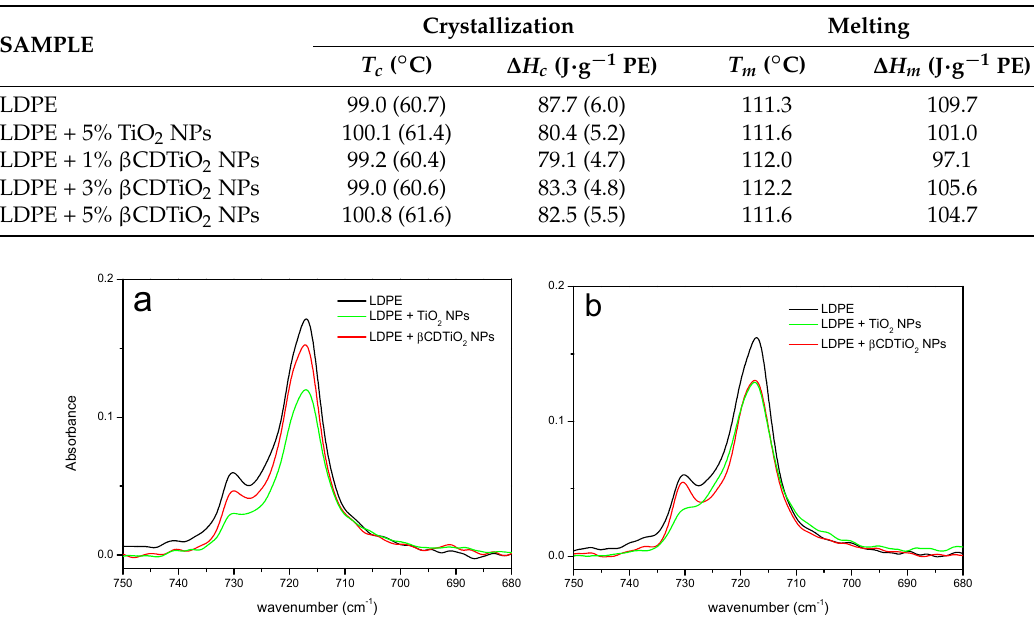
Figure 8. FTIR-ATR spectra in the 750–680 cm − 1 region of LDPE, LDPE + 5% TiO 2 NPs, and LDPE + 5% β CDTiO 2 NPs films: ( a ) Crystallized at 123 °C for 2 h; ( b ) annealed at 123 °C for 24 h from a molten sample quenched at − 70 °C.